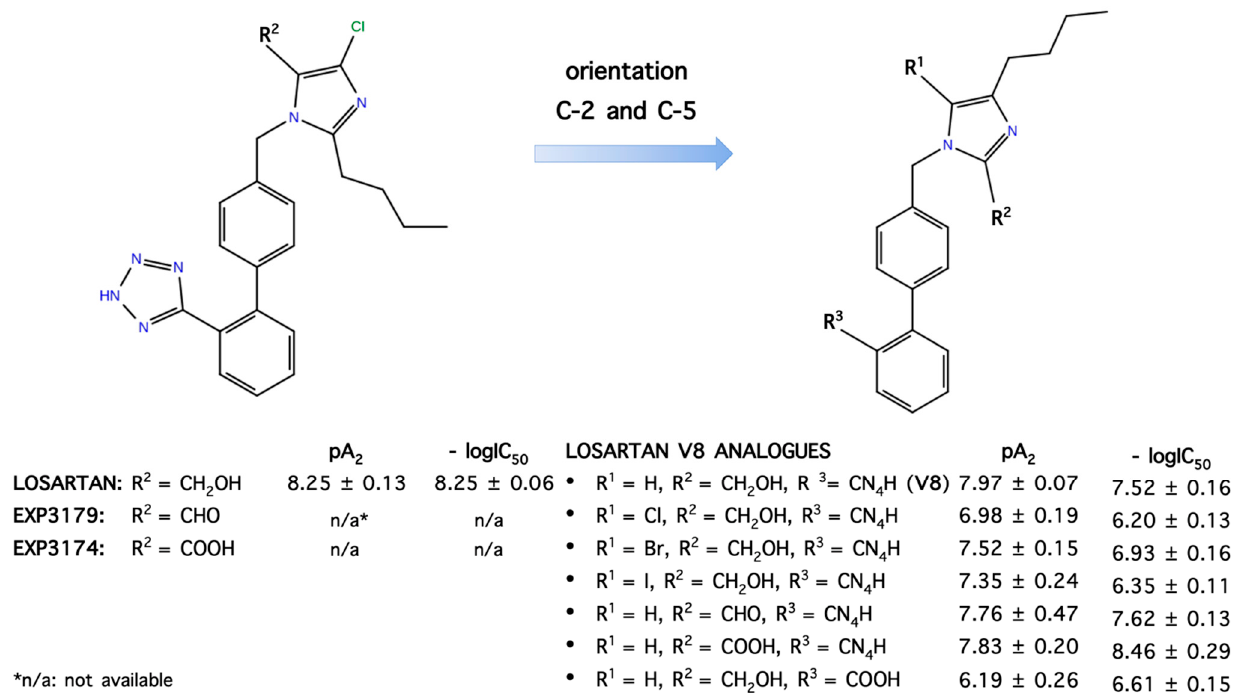
Figure 10. Structures and activities of losartan and losartan V8